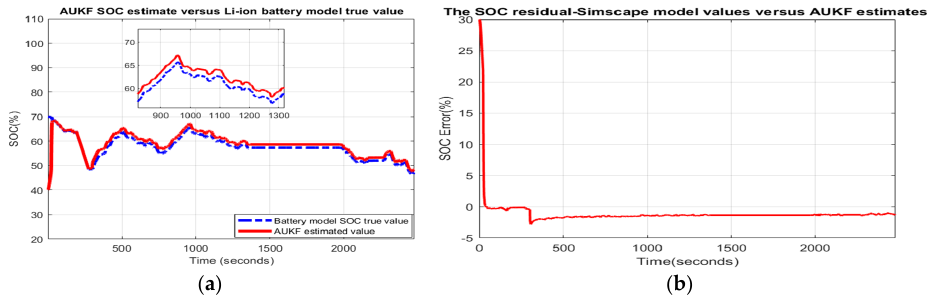
Figure A22. Robustness to changes in SOC initial value—SOCini = 0.4. ( a ) AUKF SOC estimate versus battery SOC true value; ( b ) SOC residual.